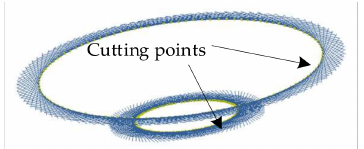
Figure 17. Generation of the cutting points.